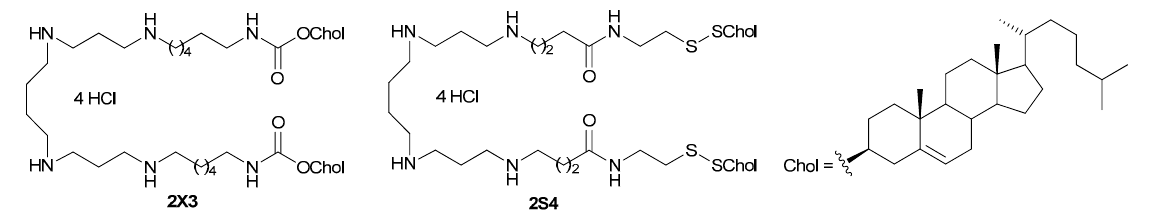
Figure 1. Polycationic gemini amphiphiles 2X3 and 2S4 .